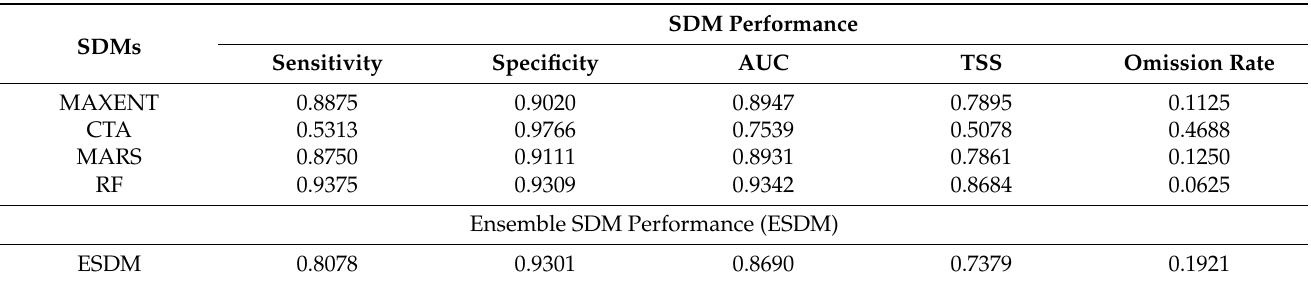
Table 1. Evaluation of each SDM and of the ESDM.